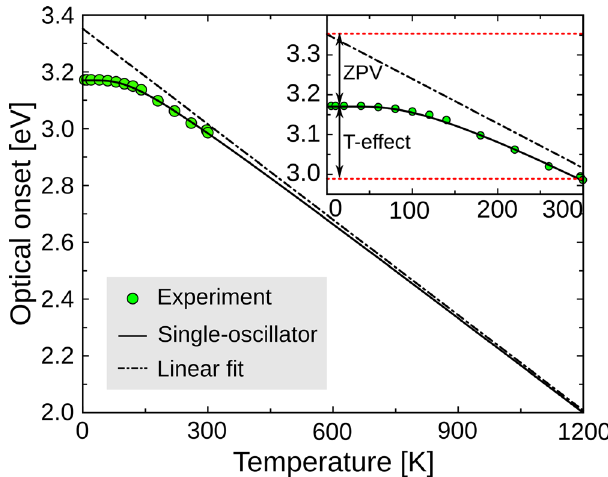
Fig. 6 Temperature dependence of the absorption onset obtained by optical-absorption measurements. The circles represent the measured data; the corresponding solid line is the best fi t based on a single-oscillator model. The dashed line shows a linear fi t for high temperatures. The inset zooms into the low-temperature region to distinguish between gap renormalization due to temperature (T-effect) and zero-point vibrations (ZPV).